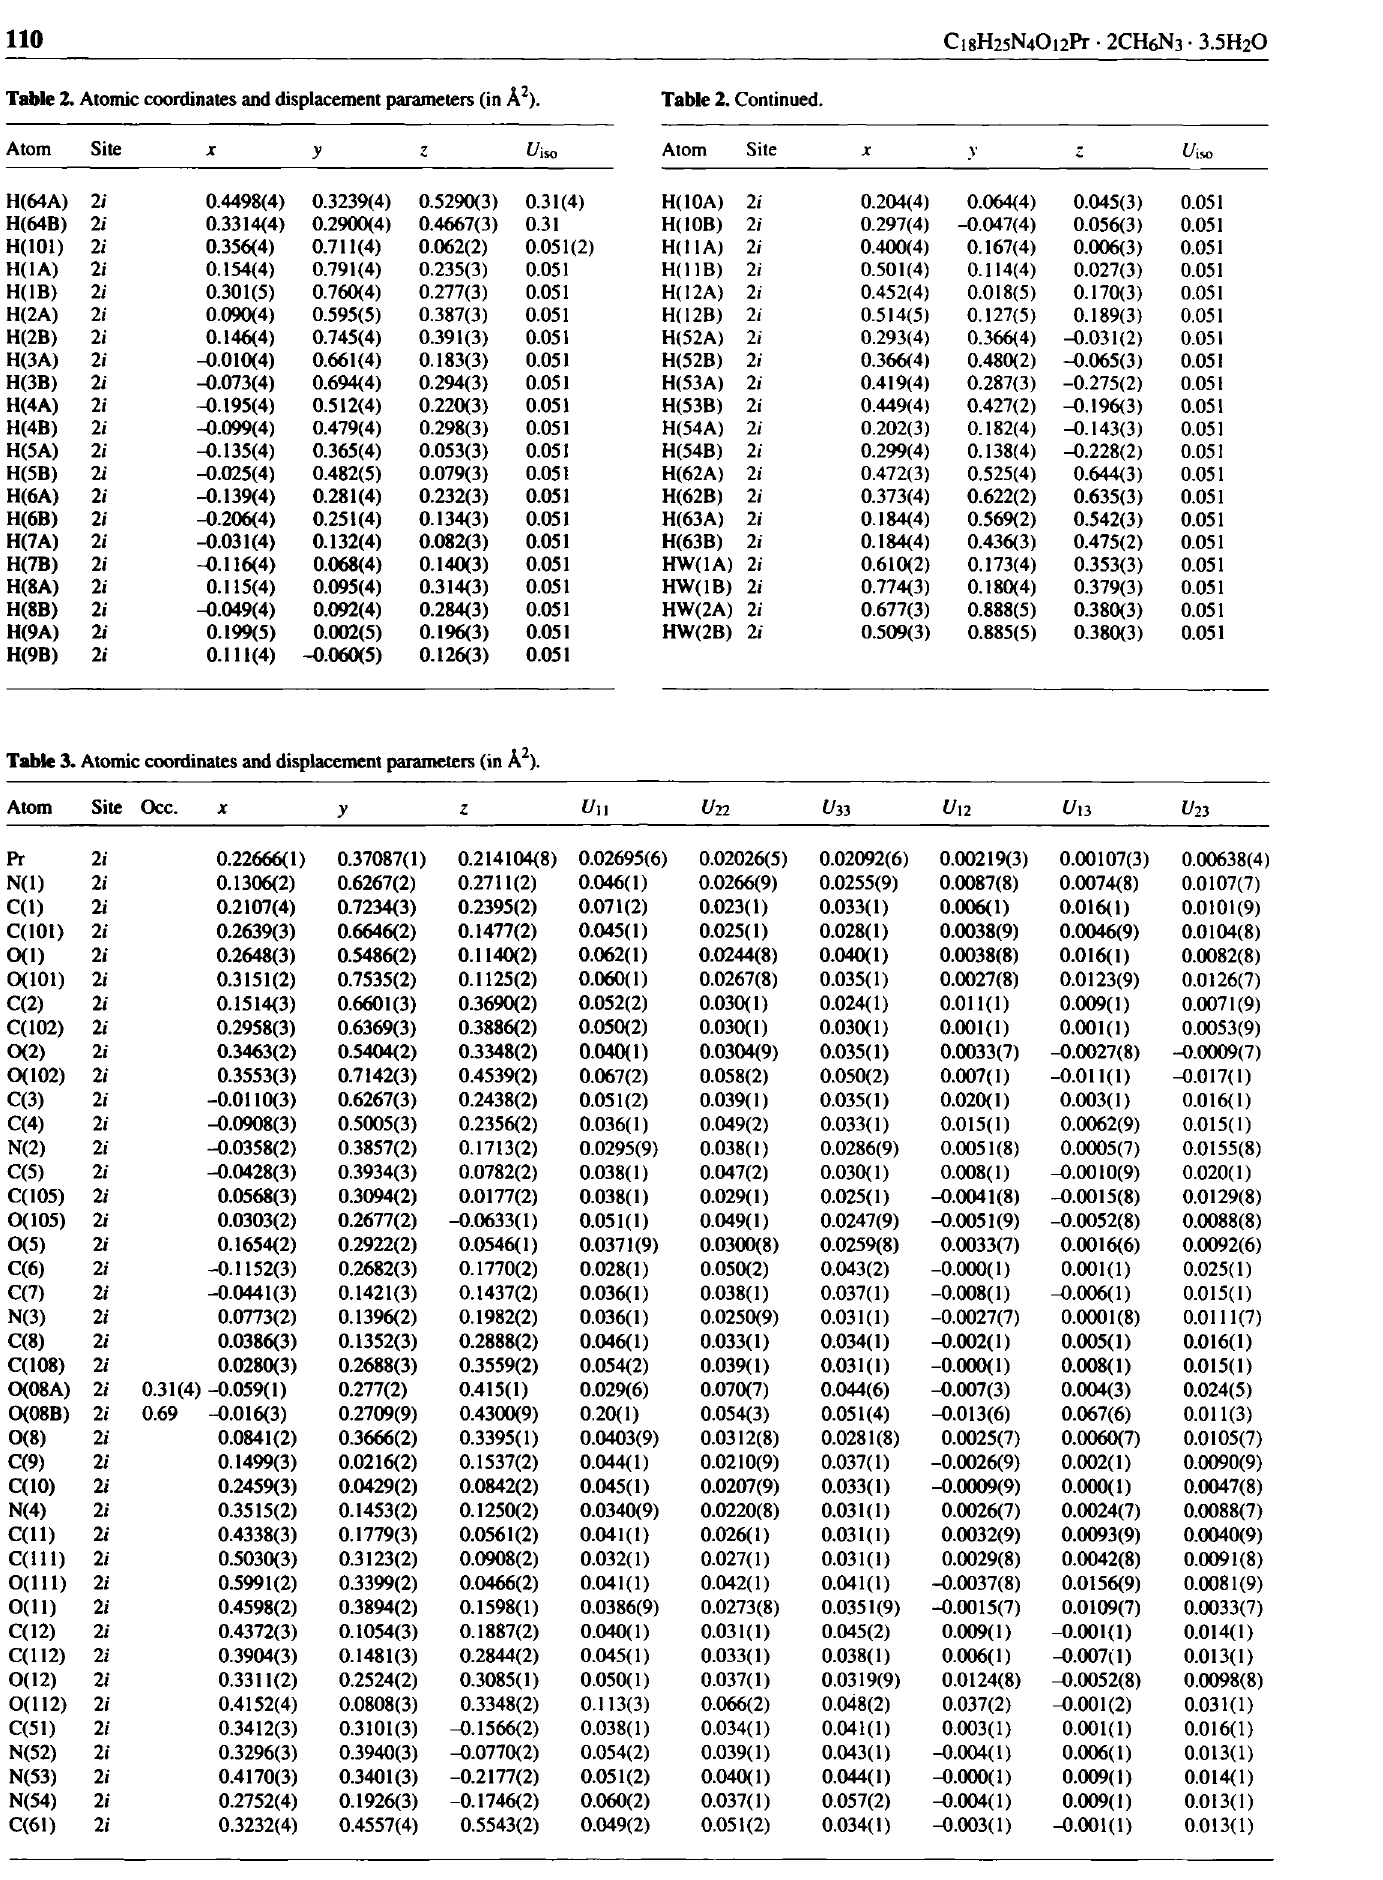
Table 2. Atomic coordinates and displacement parameters (in Â 2 ). Table 2. Continued.